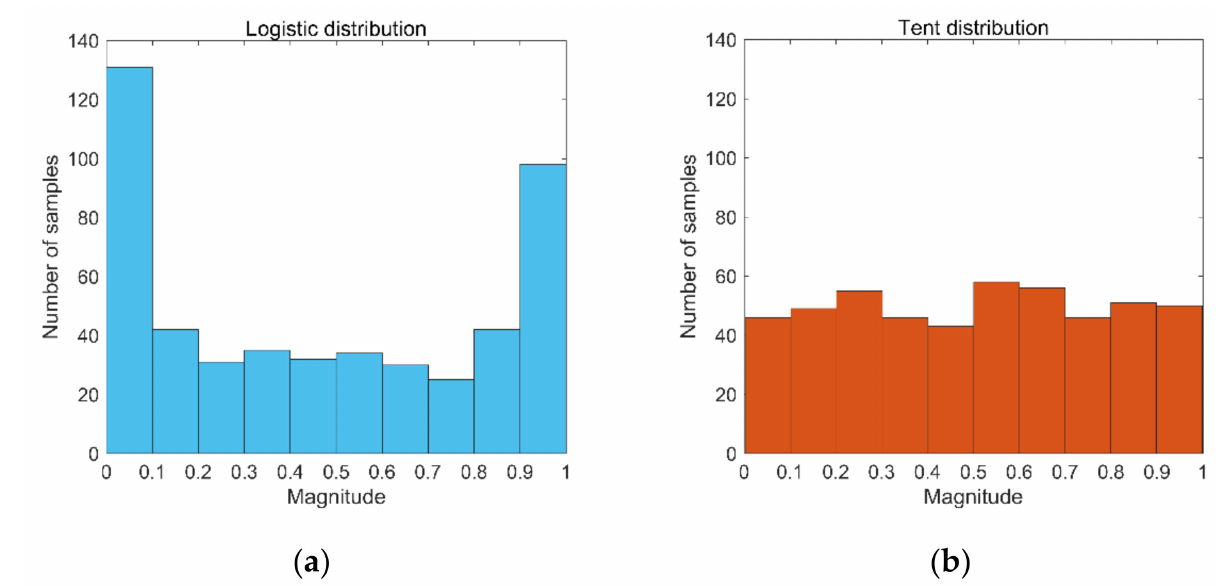
Figure 2. Distribution histogram of logistic chaotic map and tent chaotic map. ( a ) Logistic chaotic map. ( b )Tent chaotic map.